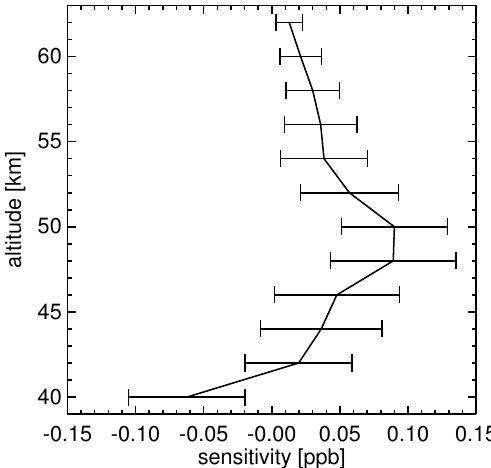
-0.15 -0.10 -0.05 -0.00 0.05 0.10 0.15 sensitivity Fig. 10. Altitude-dependent sensitivity of 1 NO 2 to the conditions Fig. 10. Altitude dependent sensintivity of ∆NO 2 on the condi- of epoch type 1 at 65 ± 5 ◦ S geomagnetic tions of epoch type 1 at 65 ± 5 ◦ S geomagnetic latitude.